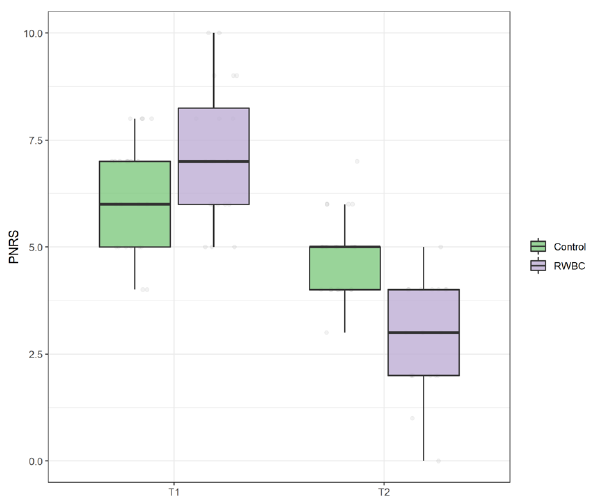
Figure 3. Boxplot of Pain Numeric Rating Scale (PNRS) scores at T0 and T1 in control group and intervention group (RWBC).